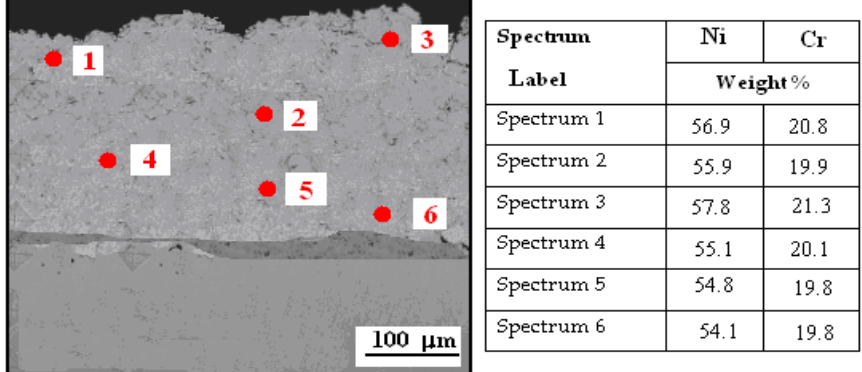
Figure 5. SEM micrograph, and EDS of PIn coating onto the S235JR substrate, and the results of point X-ray microanalysis of the chemical composition of tested material.